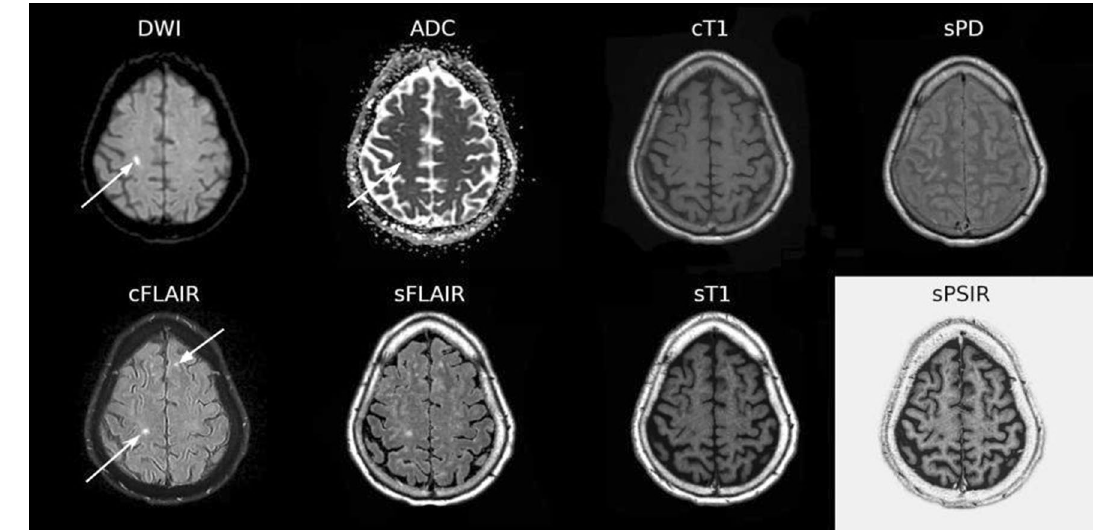
Figure 1. Axial conventional (DWI, ADC, cFLAIR, cT1) and synthetic (sFLAIR, sT1, sPD, sPSIR) weighted images depicting acute (DWI + /rADC, arrowhead) and chronic (WMH, arrow) ischemic